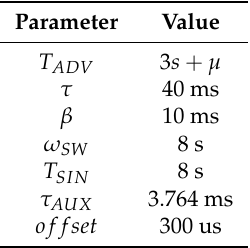
Table 4. The parameter settings in the simulation and the